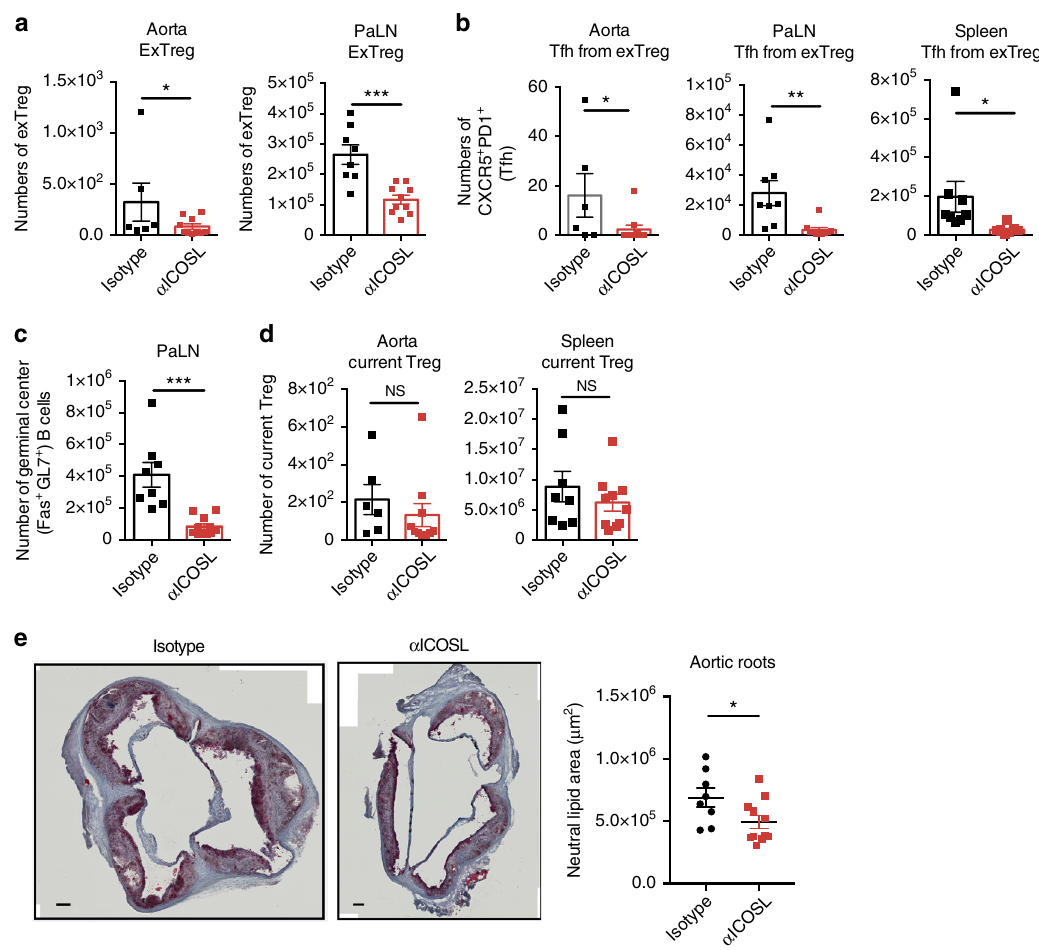
Fig. 3 Blocking ICOSL reduces exTreg Tfh cells and atherosclerosis. a – e LT-ApoE − / − mice were fed a western diet for 9 weeks and then were injected with antibody against ICOSL or isotype i.p. (100 μ g per mouse, twice per week) for 6 weeks. Graphs show the numbers of exTreg ( a ), exTreg Tfh cells ( b ) in aorta, PaLN and spleen, germinal center B cells in PaLN ( c ) and current Treg cells in aorta and spleen ( d ). e Oil Red O stain of aortic roots from the above mice. Images are representative section from each group of mice. Each individual dot in the graph is the average of at least 4 sections per aorta per mouse. Scale bars = 100 μ m. Results are expressed as mean ± s.e.m. from two independent experiments (For aorta, n = 6 (isotype) and n = 10 ( α ICOSL). For PaLN and spleen, n = 8 (isotype) and n = 10 ( α ICOSL). For aortic roots, n = 8 (isotype) and n = 11 ( α ICOSL). Statistical signi fi cant differences were at * P < 0.05, ** P < 0.01, and *** P < 0.001 (unpaired Student ’ s t